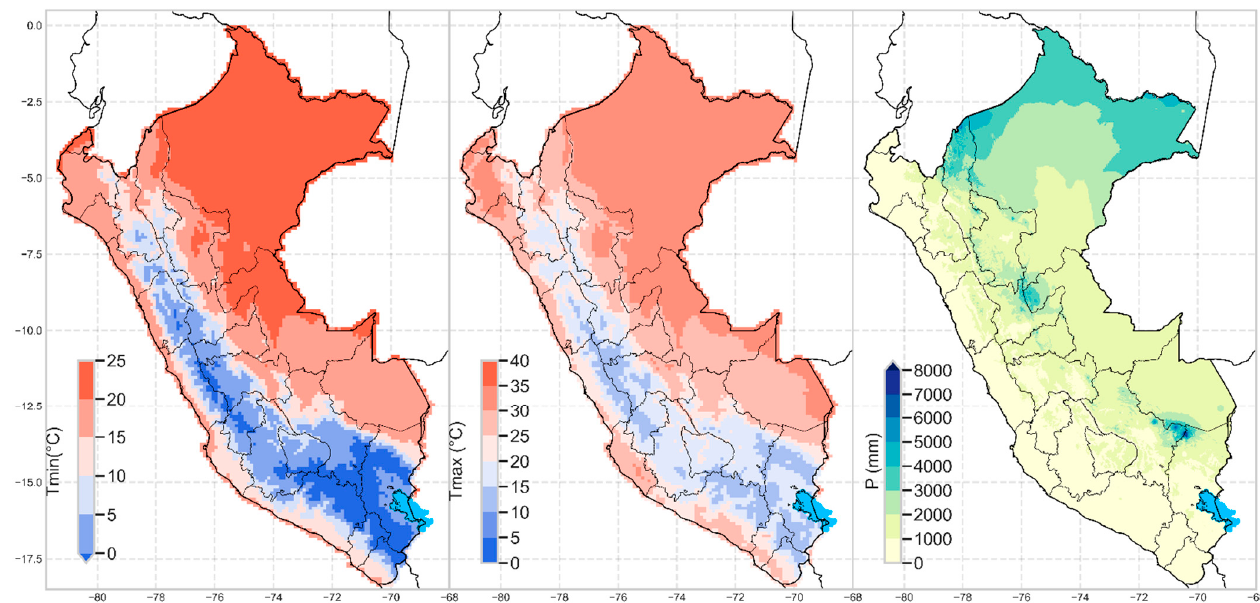
Figure 1. Multi-year climatology (1981–2010) of left: minimum temperature (°C), center: maximum temperature (°C), and right: precipitation (mm).